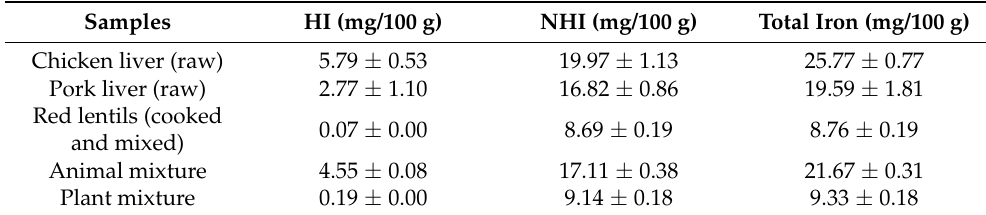
Table 5. Mean contents of the different forms of iron measured on the raw materials and on the 3D-printed matrices.